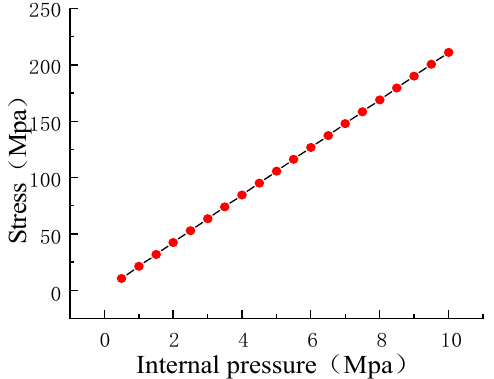
Figure 3. Relationship between pressure and stress in pipeline .